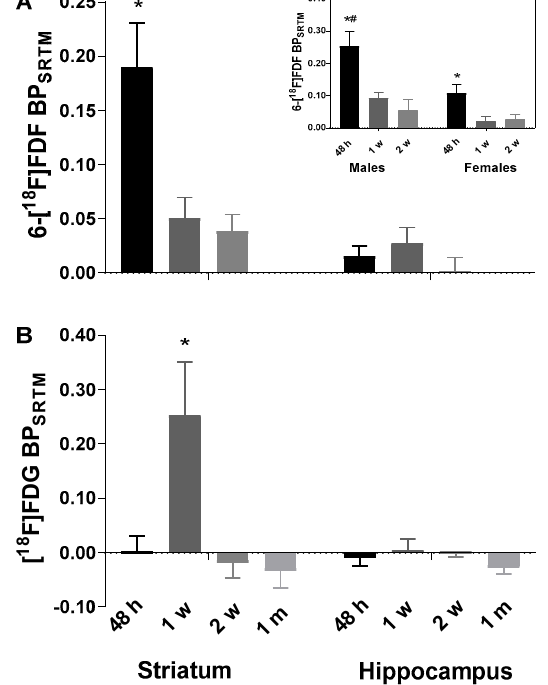
Figure 3. Binding potential ( BP SRTM , ± SEM) of 6-[ 18 F]FDF ( A ) and [ 18 F]FDG ( B ) in unilateral lipopolysaccharide-injected right striatum of rats. BP SRTM was derived from simplified reference tissue model (SRTM) using contralateral side as the reference tissue. Inset in ( A ) shows separate striatal 6-[ 18 F]FDF data for male and female rats. * P < 0.05, 6-[ 18 F]FDF at 48 h vs. other time points and [ 18 F]FDG at one week vs. other time points in the striatum; # P < 0.05, male vs. female rats in 6- [ 18 F]FDF uptake at 48 h (one-way ANOVA followed by Bonferroni corrections).